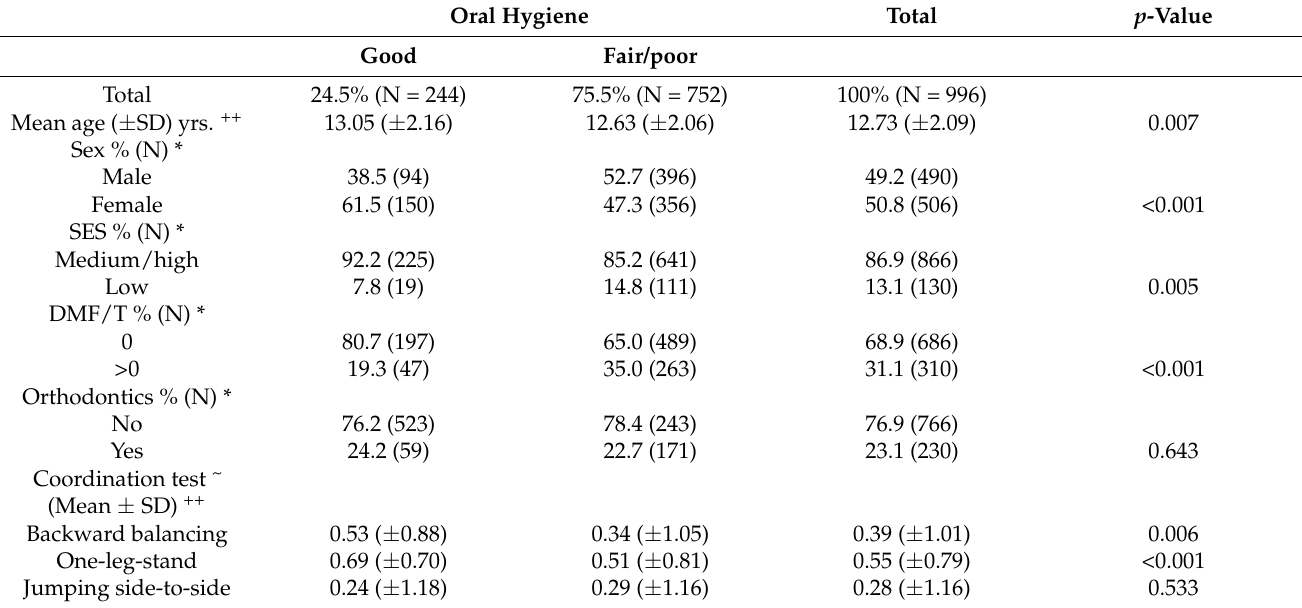
Table 1. Association of oral hygiene and SES, sex, age, orthodontic treatment, DMF/T and coordina- tion skills in children and adolescents of 10 to 18 years (Leipzig, Germany). Oral Hygiene Total p -Value Good